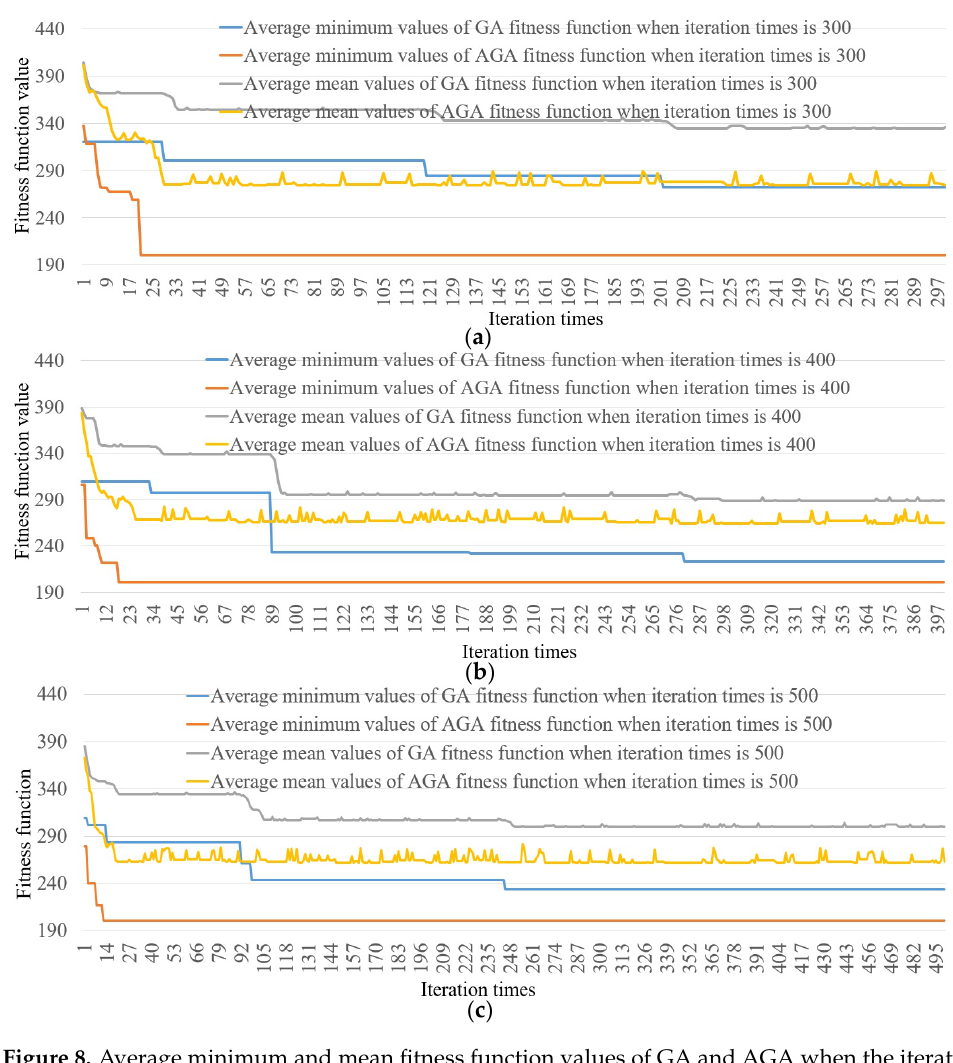
Figure 8. Average minimum and mean fitness function values of GA and AGA when the iteration times are 300, 400, and 500. ( a ) Statistical evaluation results of fitness function when the iteration times is 300. ( b ) Statistical evaluation results of fitness function when the iteration times is 400. ( c ) Statistical evaluation results of fitness function when the iteration times is 500. Table 6. Evaluation results of GA and AGA using different experiments and iteration